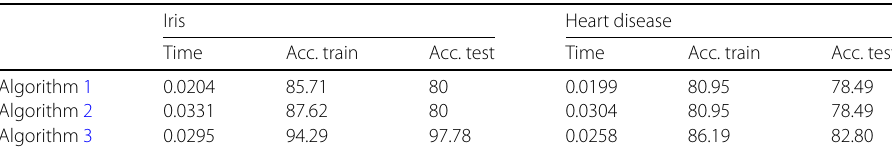
Table 8 Accuracy comparison of each algorithm at the 100th iteration